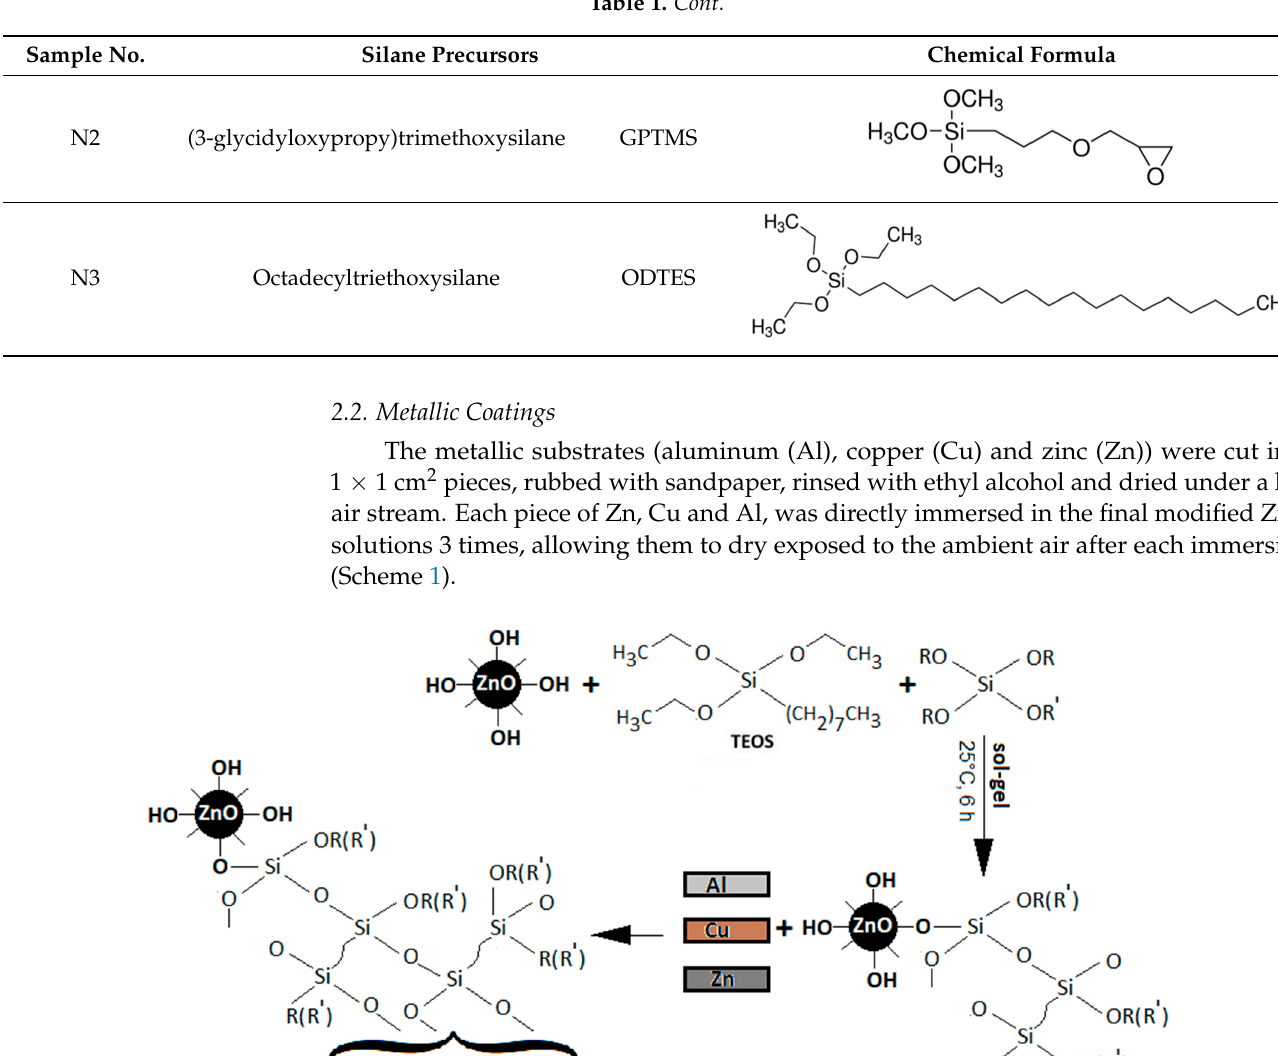
Table 1. Silane precursors and their chemical formulae.